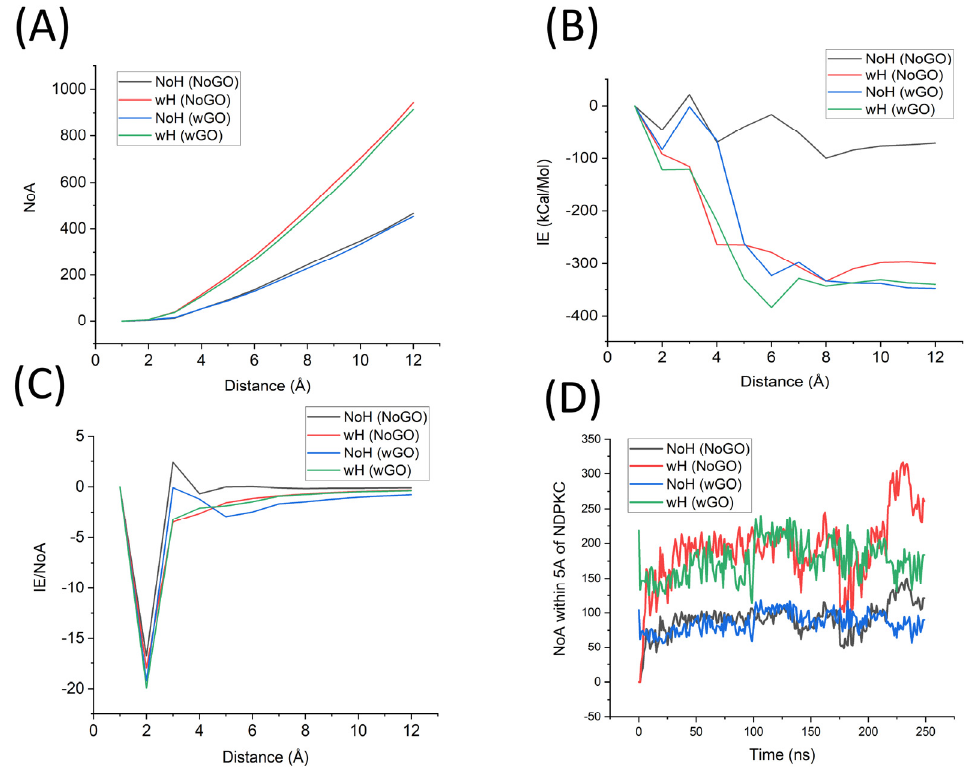
Figure 7. Optimal distance analysis between NDPK-B and NDPK-C: ( A ) Number of atoms between NDPK-B and NDPK-C as a function of distance in the presence and absence of GO with and without hydrogen atoms; ( B ) Interaction energy between NDPK-B and NDPK-C as a function of distance in the presence and absence of GO with and without hydrogen atoms; ( C ) Maximum interaction energy per atom between NDPK-B and NDPK-C in the presence and absence of GO with and without hydrogen atoms; ( D ) Number of atoms (NoA) of NDPK-B within 5 Å of NDPK-C with respect to time in the presence and absence of GO with and without hydrogen atoms.